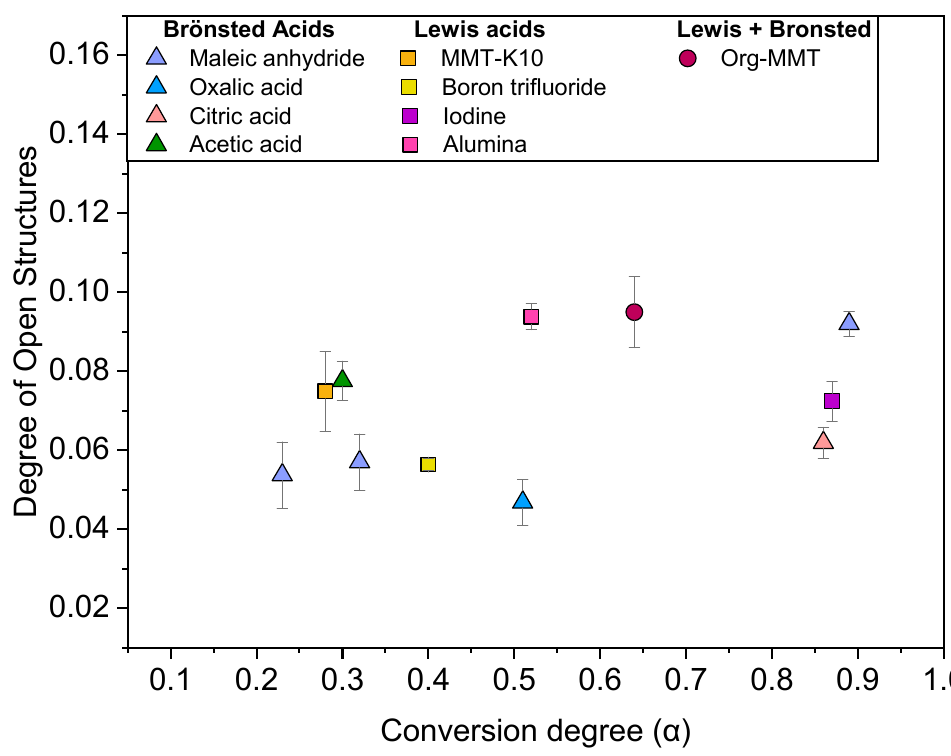
Figure 1. Comparison of the degree of open structures obtained from titration method synthesized with different initiators in function of the conversion degree.